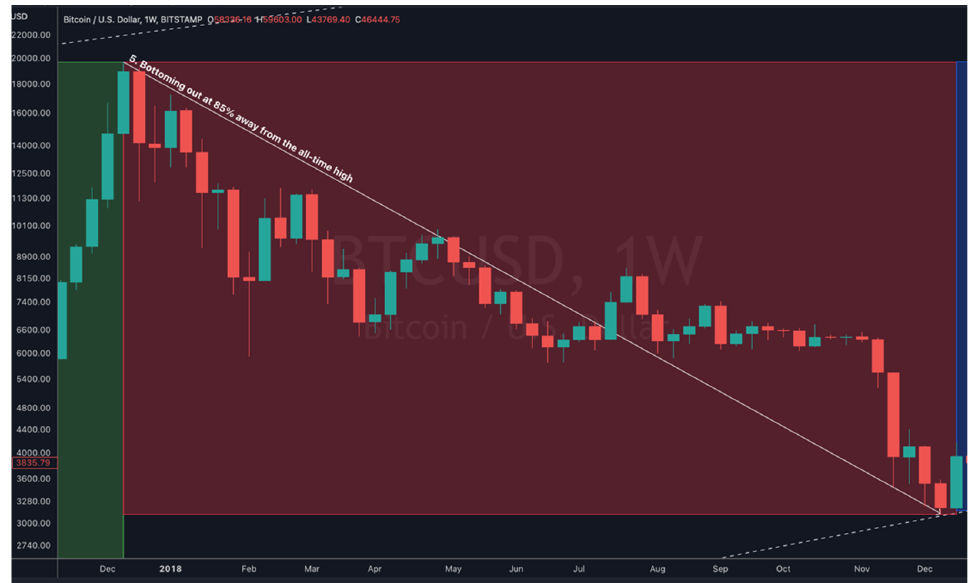
Figure 5. The 5th sequence of the 2017 bear market during the Bitcoin 2016–2020 halving cycle. Sim- ilar to Figure 3, the Bitcoin price ended the bear market by bottoming at $3100 (approximately 85% away from the historical all-time high) before entering the recovery phase again.